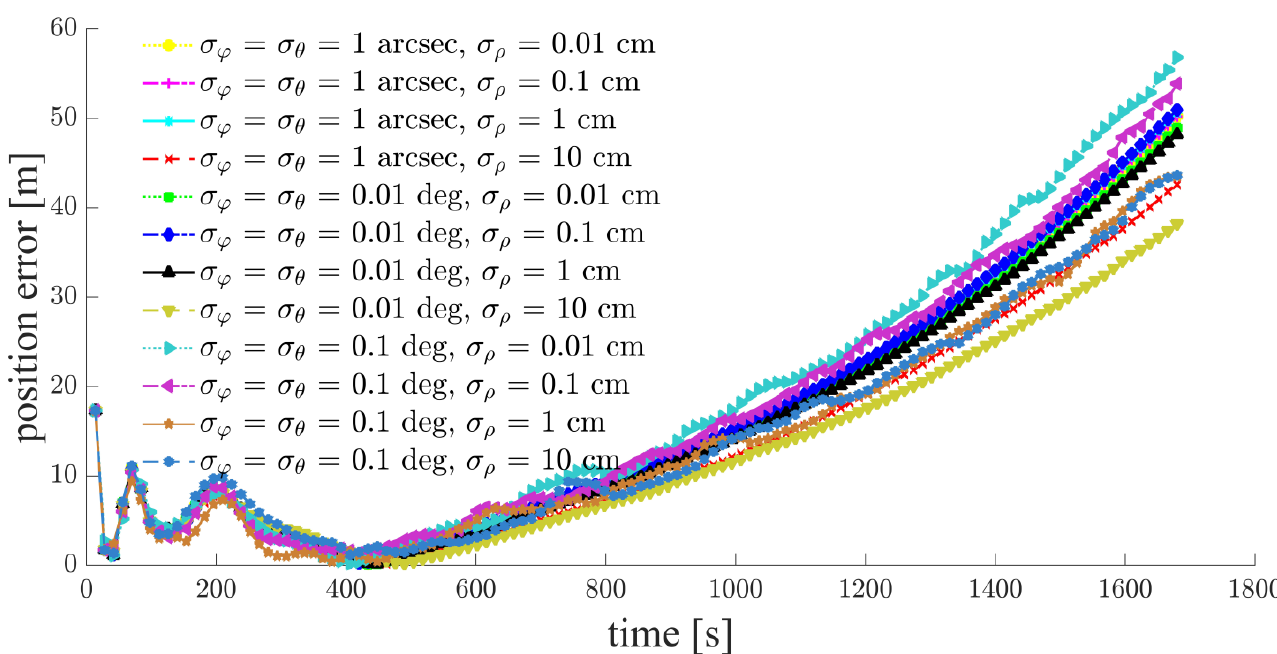
19 of 23 Table 4. Multi-satellite relative navigation results (simulated scenario: Cases a – d, space-circle for- mation radius of 1 km, 𝜎 𝜑 = 𝜎 𝜃 = 0.01 deg,𝜎 𝜌 = 1 cm ).